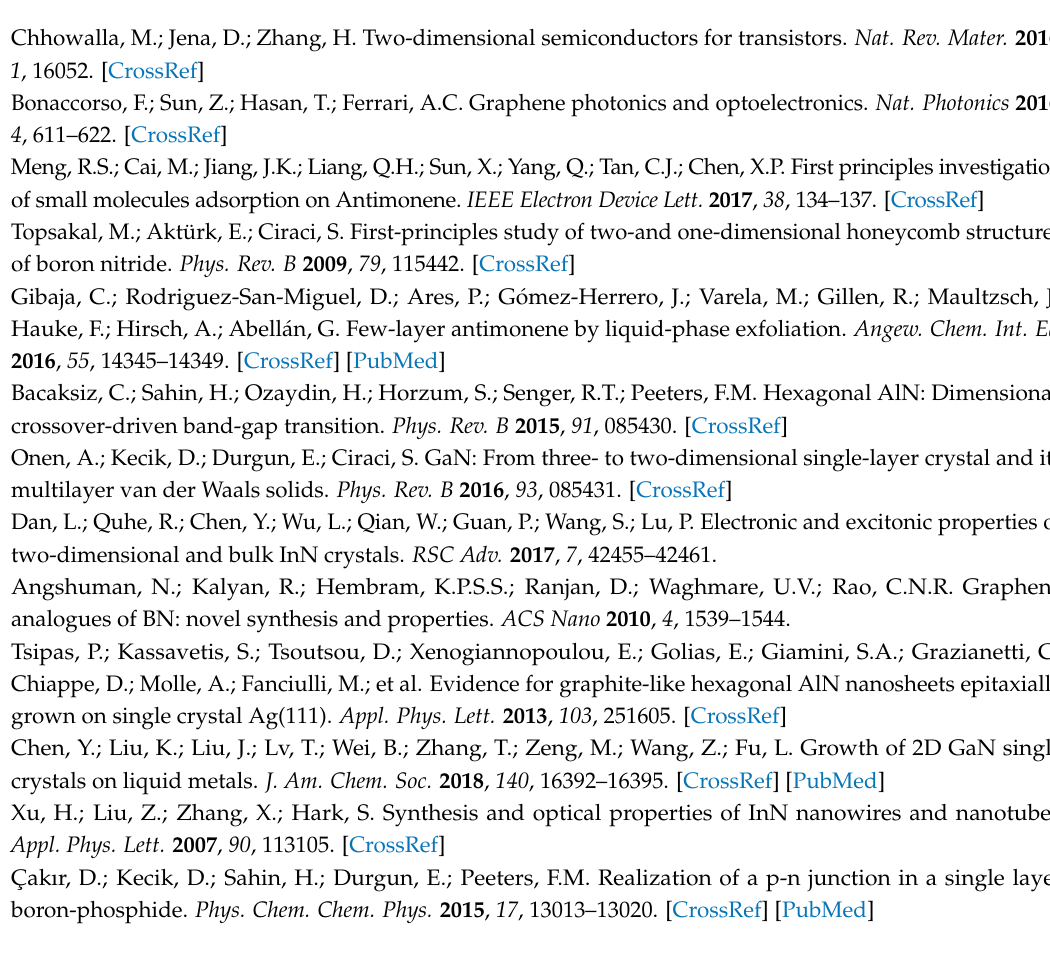
Figure S1: Band structures of pristine (a) BN, (b) AlN, (c) GaN, (d) InN, (e) BP, and (f) P.